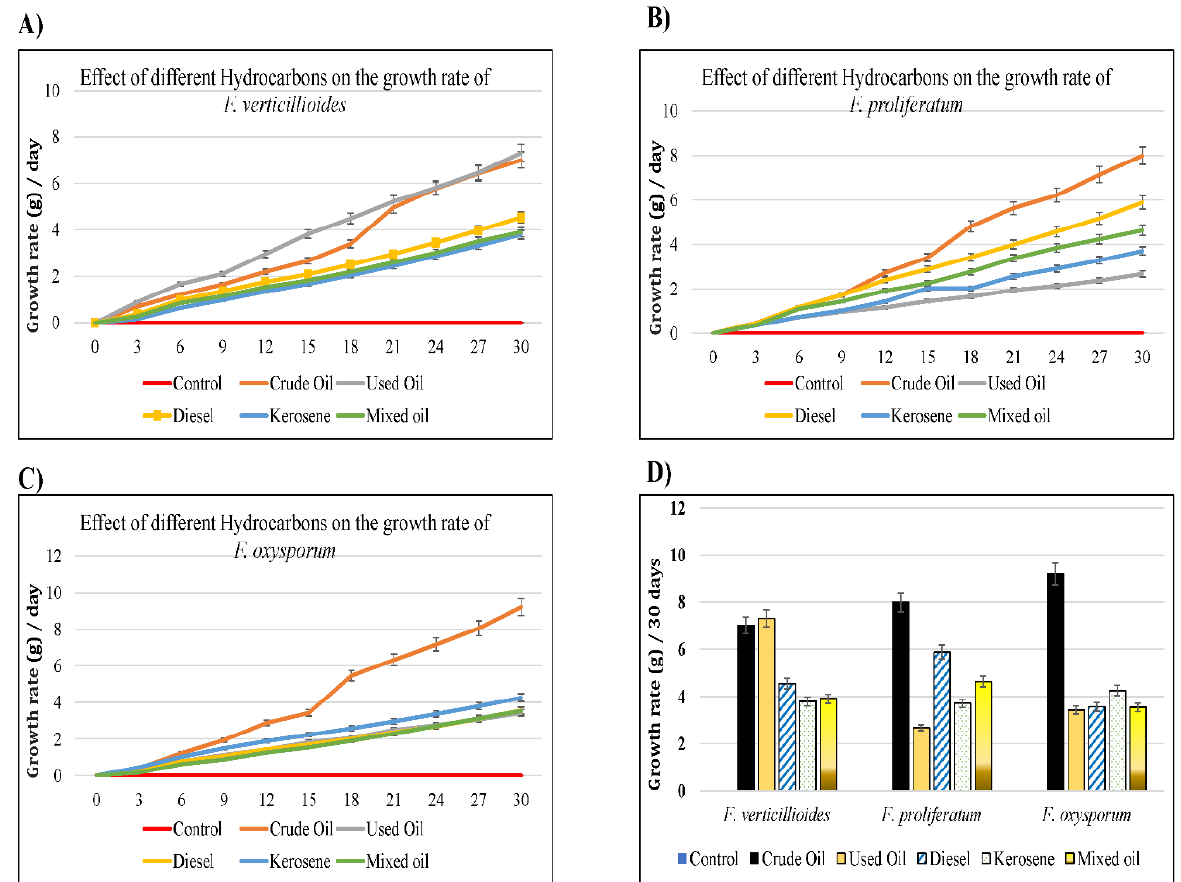
Figure 3. Charts showed the hydrocarbons tolerance of three Fusarium species growing on MSM liquid medium with 1% of the studied hydrocarbons versus the control (water) for 30 days. ( A ) growth rate of F. verticillioides ; ( B ) growth rate of F. proliferatum , ( C ) growth rate of F. oxysporum, ( D ) comparison of the net increment of the growth rates of isolated species on the 30th